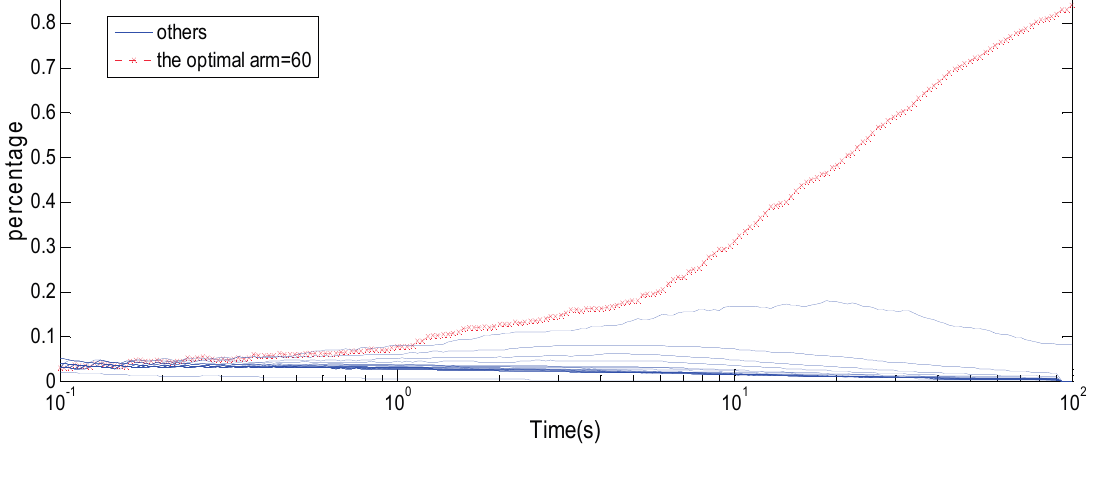
Figure 13. The optimal arm for the same wireless network quality.